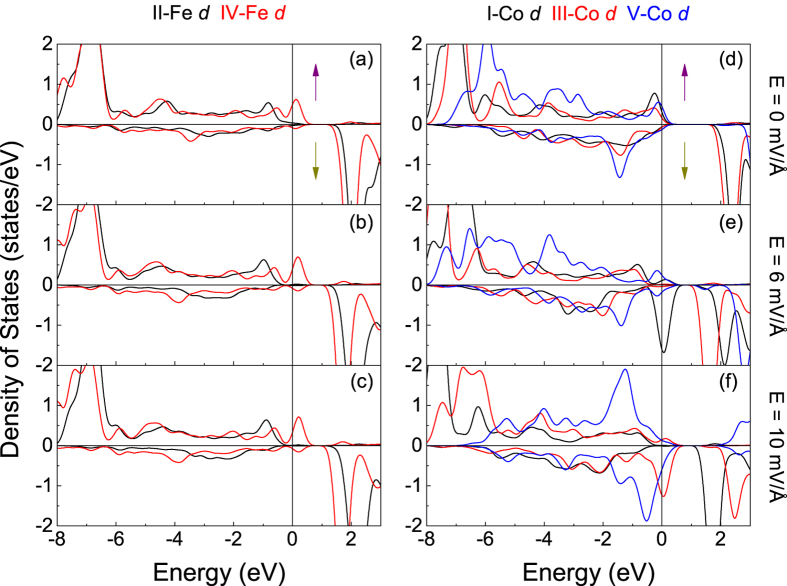
Partial DOS for (a–c) Fe and (d–f) Co in each layer of model CoO2-BiO on different values of electric field. EF = 0 eV.